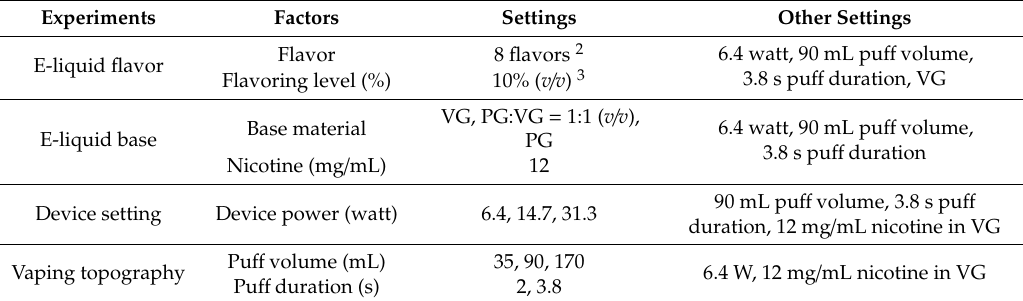
Table 1. E-vapor generation conditions used in this study 1